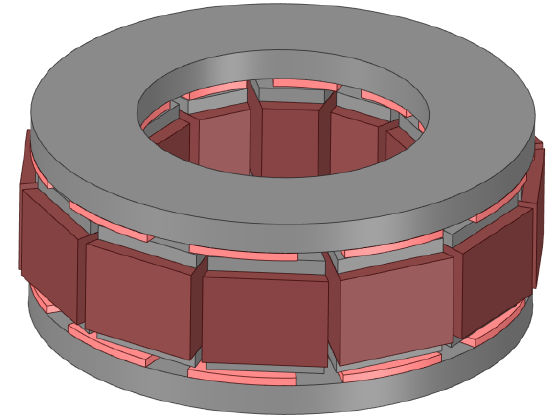
Figure 2. Configuration of the YASA machine. Table 1. Key parameters of the YASA machine.